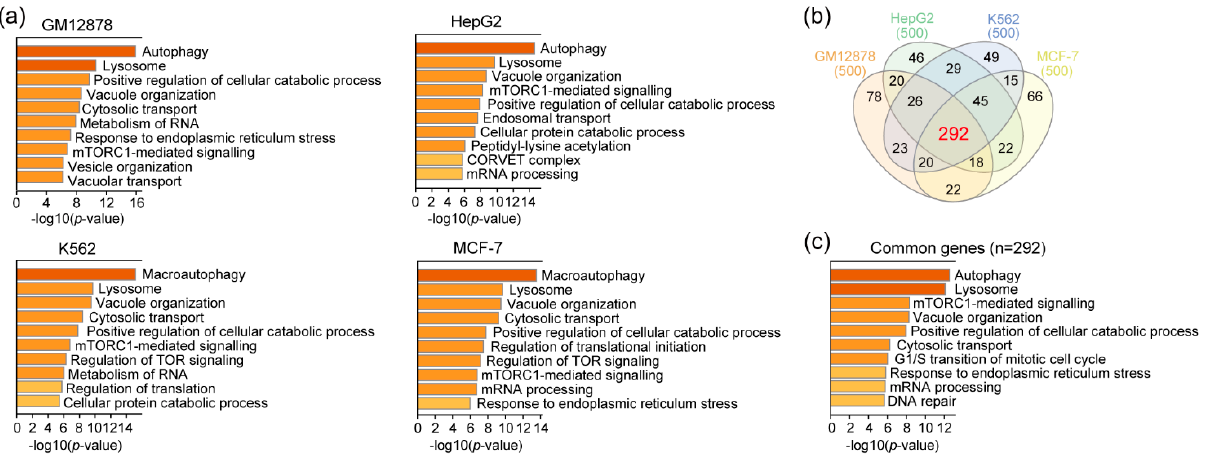
Figure 3. Predicted biological pathways associated with the top 500 RAD51 binding sites. ( a ) Gene ontology analysis was performed using Metascape [34] with the nearest genes of the top 500 RAD51 binding sites. ( b ) The Venn diagram shows the number of overlapping RAD51 target genes between cell lines. ( c ) Biological pathways that were related to common RAD51 target genes were